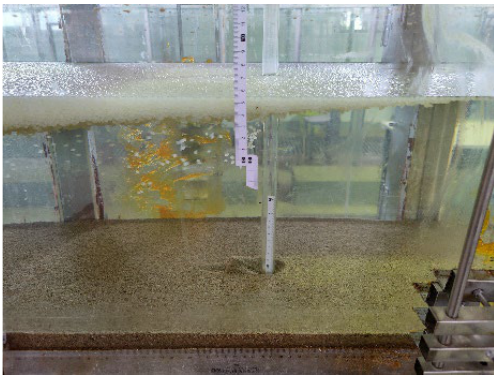
Figure 12. Transportation of ice particles.